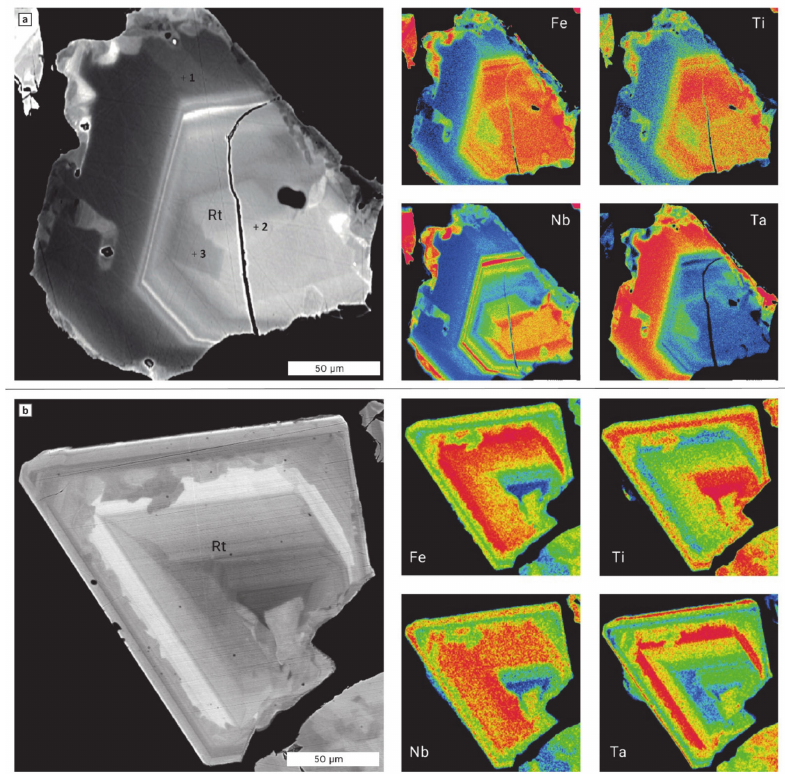
Figure 6. ( a , b ) SEM/energy-dispersive spectrometry (EDS)-BSE images of two Nb-Ta-rich rutile grains with characteristic zoning of Fe, Nb, Ti, and Ta and their compositional maps. Explanation: Rt = rutile. Numbered crosses depict position of point chemical analyses (see Table